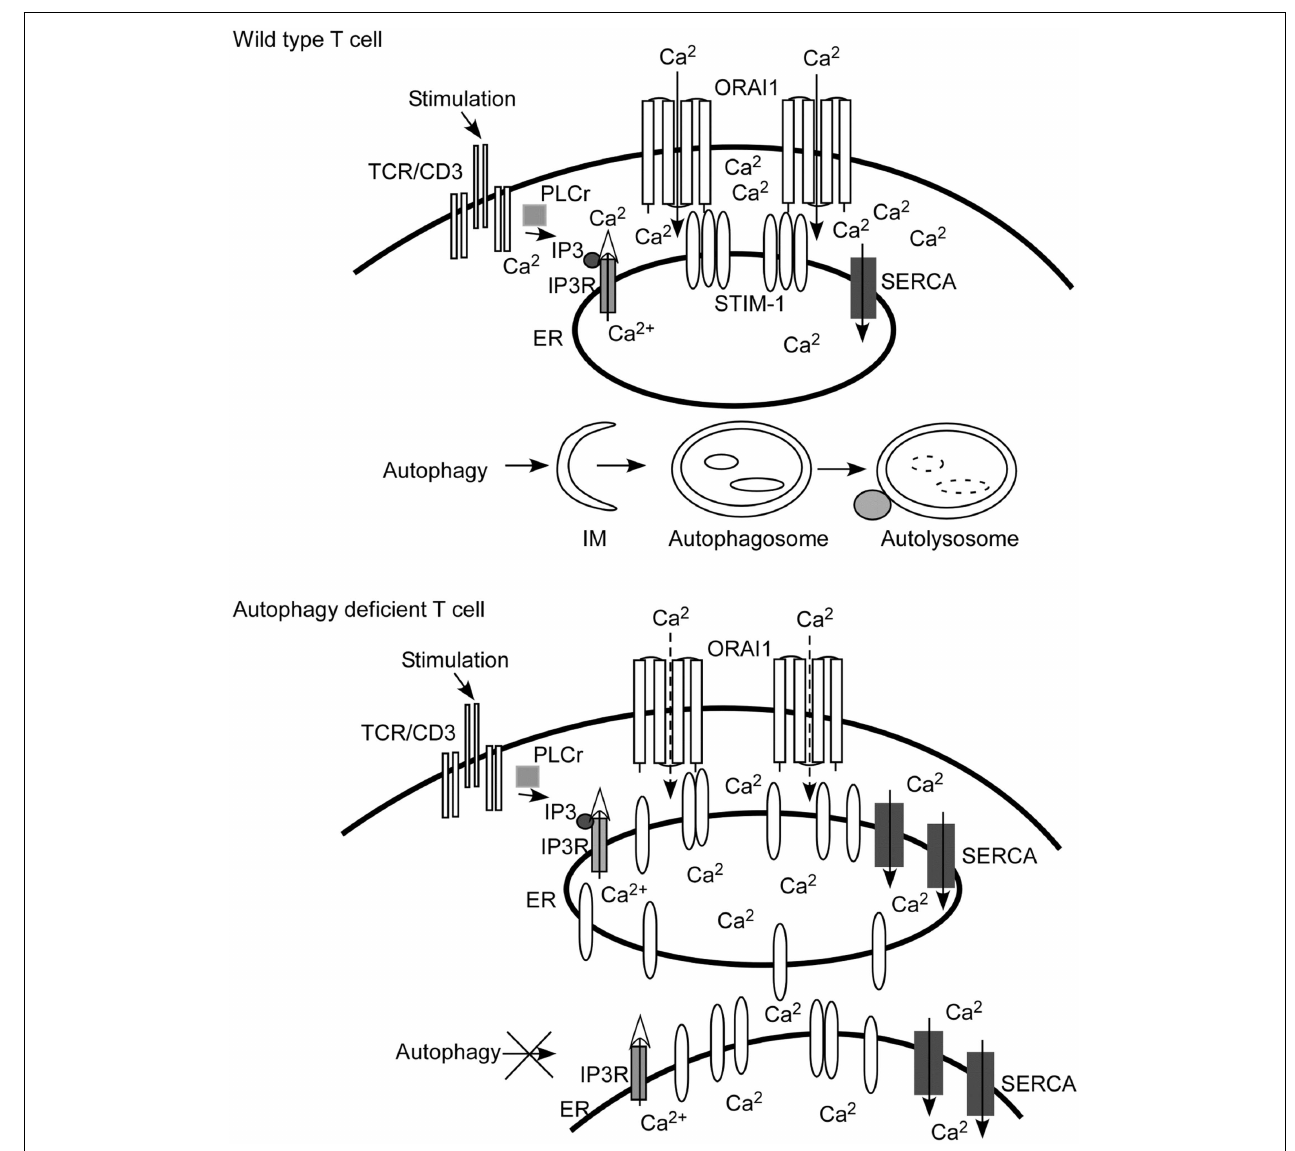
release-activated Ca 2 + (CRAC) channels, ORAI1, to open CRAC channels. Extracellular calcium fluxes through CRAC channels into the cytoplasm ofT cells (visualized as Ca 2 + inside of the cells).When autophagy is ablated, as shown in the cartoon figure of autophagy-deficientT cells, the contents of the ER are expanded. Calcium stores are increased since the ER is expanded and more sarcoplasmic/endoplasmic-reticulum Ca 2 + -ATPase (SERCA) are expressed.The depletion of calcium stores is incomplete and less STIM1 redistributes to the ER plasma junction.Therefore, less CRAC is opened.The end result is that calcium influx is defective compared to that of wild typeT cells. IM, isolation